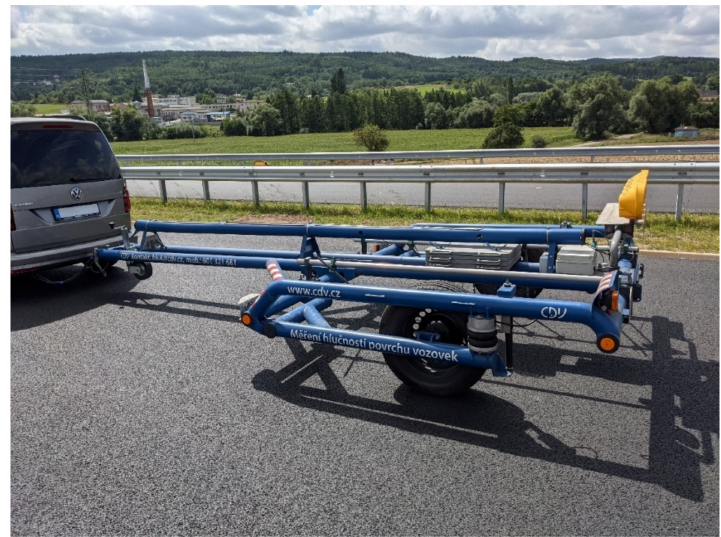
Figure 1. The CPX trailer designed by CDV, photo 2021 (source: Transport Research Centre (CDV)).